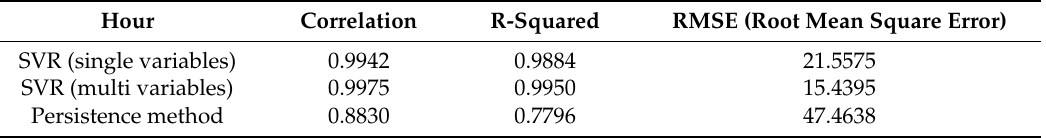
Table 5. Accuracy of SVR model and Persistence method (11 January